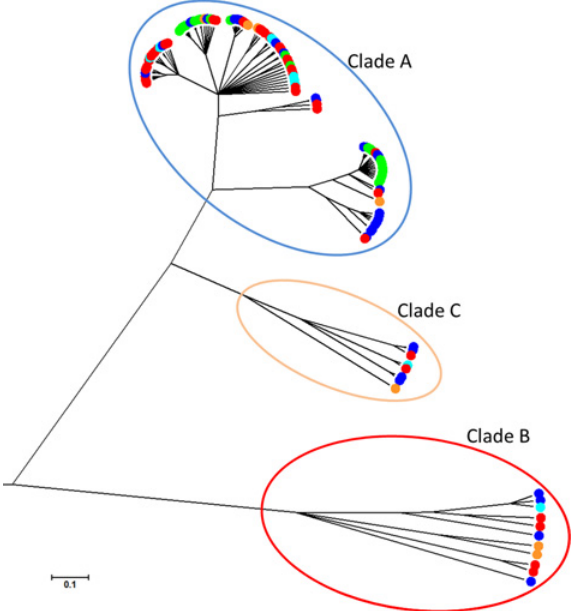
Fig 1. Population structure of 117 S. epidermidis isolates constructed from 53 rMLST genes and implemented in CLONALFRAME, with the 3 clades highlighted. The scale (0.1) represents the number of substitutions per site. Isolates are coloured according to source: PJI (blue); catheter (green); undefined infection (orange); healthy nasal and skin (red); animal (turquoise).